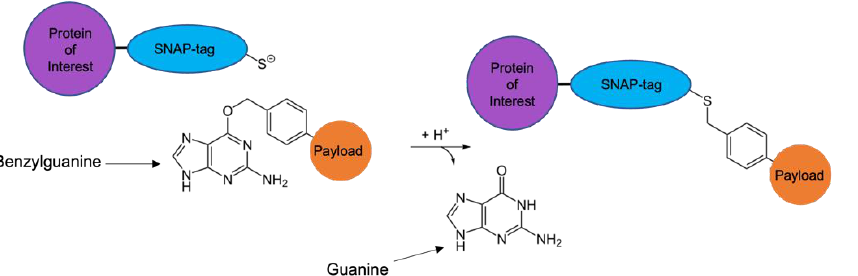
Figure 3. Autocatalytic reaction between SNAP-tag and BG-modified substrate. The benzyl alkyl group of the BG bonds covalently with the reactive cysteine residue on the SNAP-tag, forming a thioether; guanine is released in the reaction. The SNAP-tag fusion protein is now labelled with the payload molecule in a known DAR (1 to 1) and with a homogenous configuration.